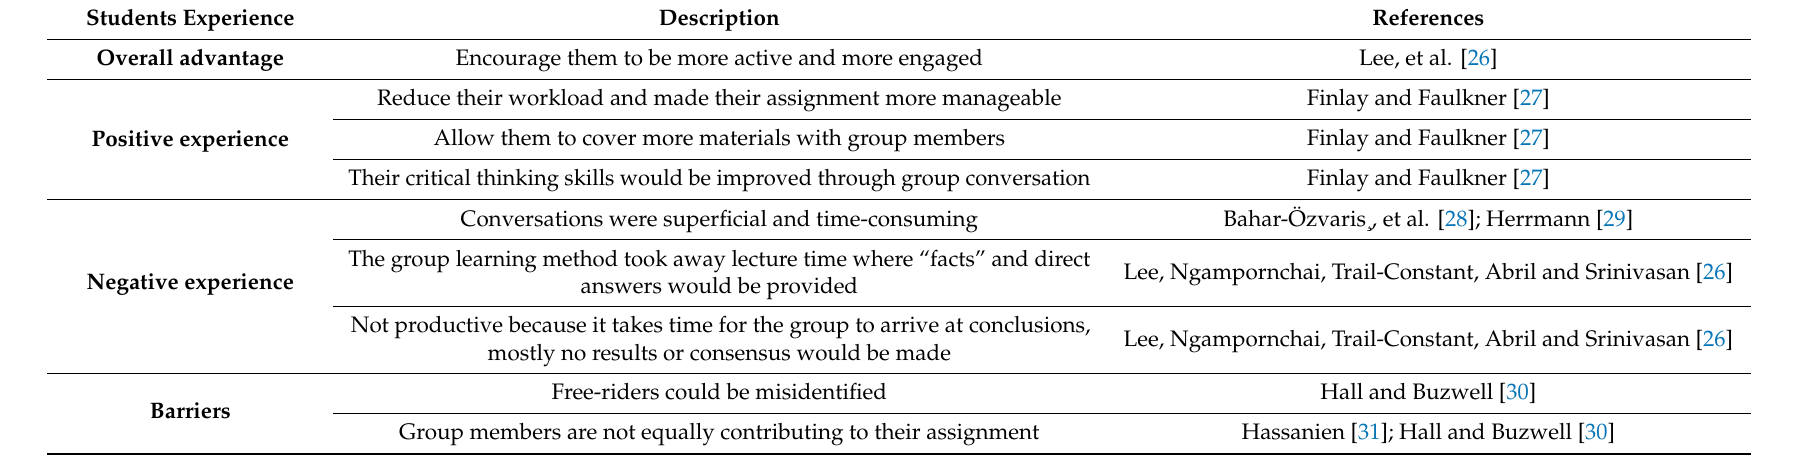
Table 1. Overall advantages, experience, and barriers to group project